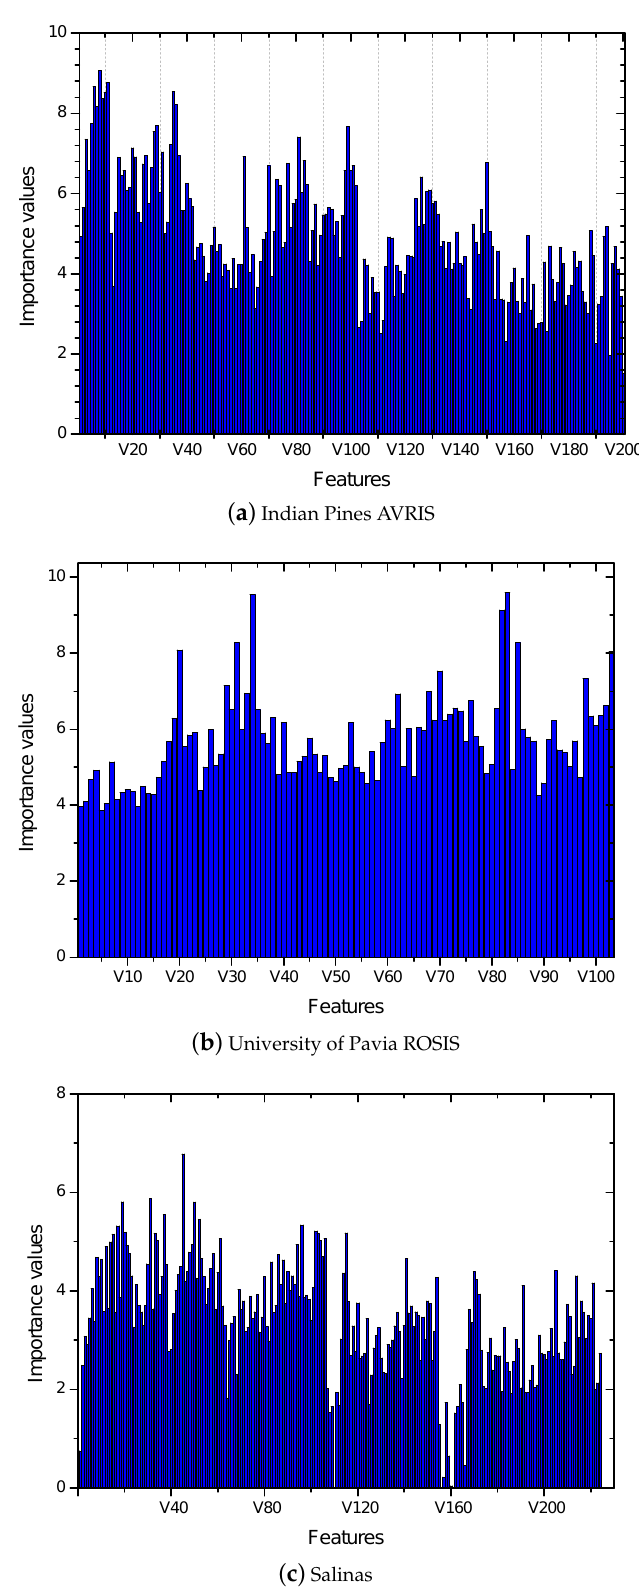
Figure 1. Feature importance values of the hyperspectral data Indian , University and Salinas